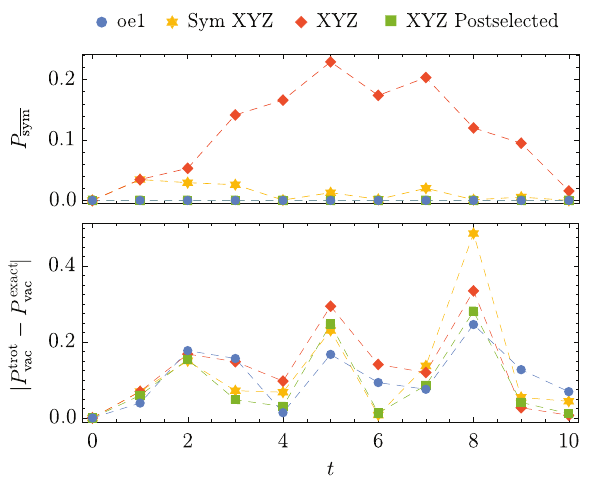
FIG. 3. The leakage to the symmetry-forbidden sector, P sym , defined as the population in the states with a nonvanishing total charge given a bare-vacuum initial state (upper panel), as well as the error in the bare-vacuum population (lower panel) are shown for the odd-even ordering (blue dots), the XYZ ordering before (red diamonds) and after (green squares) postselection, as well as the XYZ ordering with symmetry protection but with- out postselection (yellow stars). The parameters used for the plot are μ = 0.1, x = 0.6, N = 4, and δ t = 1. The optimal angles for the symmetry-protected simulation are provided in Appendix A. Sym XYZ refers to symmetry-protected XYZ ordering.